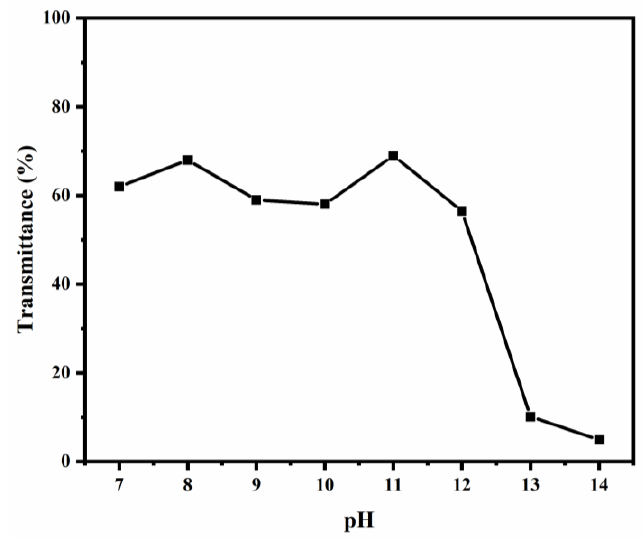
Figure 4. Transmittance of the PBA-g-PDMAEMA solution at different pH values.